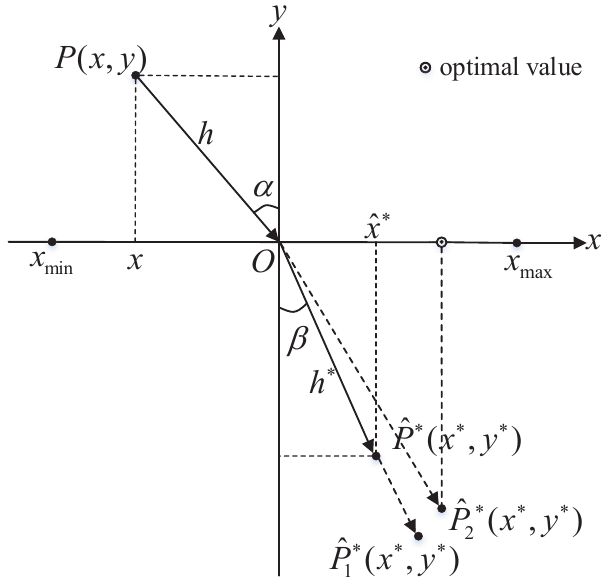
Figure 4. The process of refraction